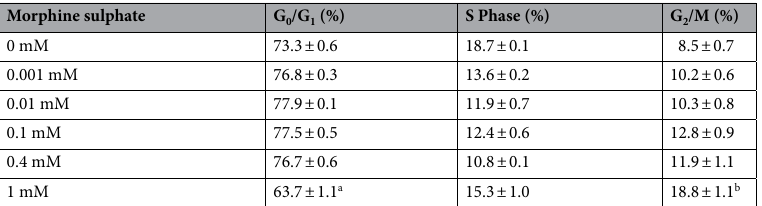
Table 1. Flow cytometry analysis carried out after eighteen days of 1 mM morphine sulphate exposition highlighted significant differences in the observed cells percentage respectively in G0/G1( a P < 0.0001) and in G2/M ( b P = 0.0001), suggesting 1 mM of morphine sulphate induces a cell cycle block in this latter phase. The reported values are expressed as mean ± SD of three independent